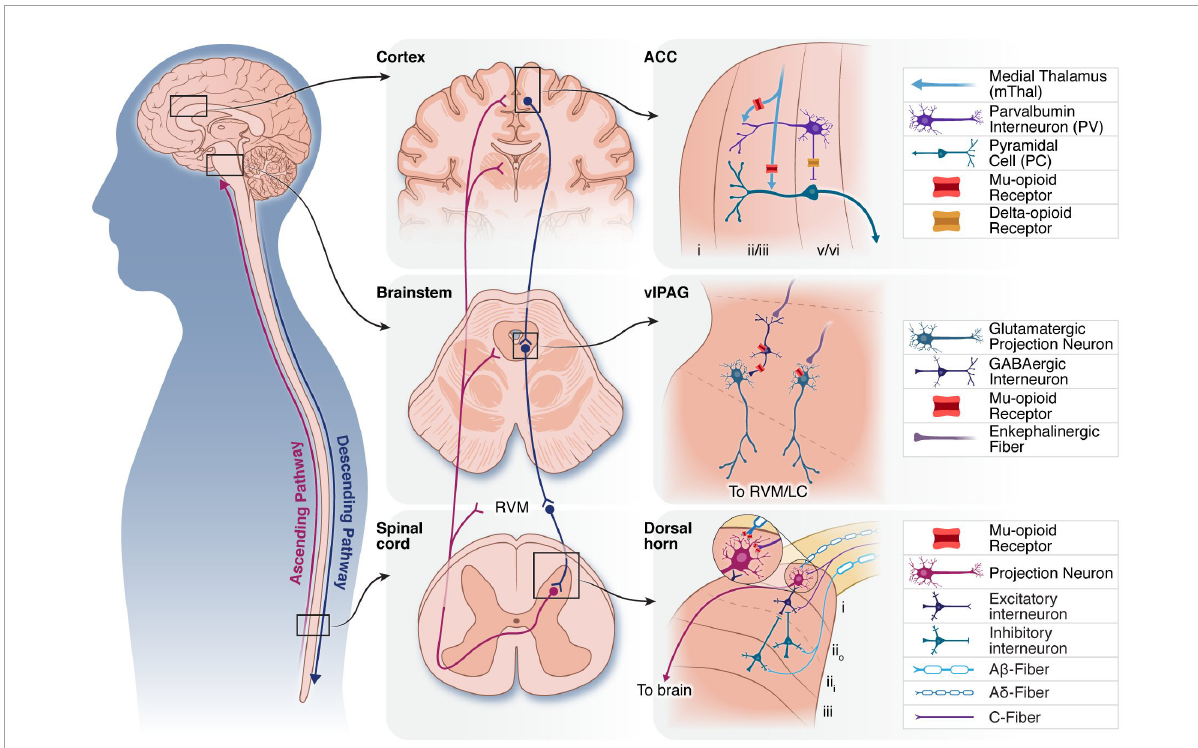
FIGURE1 Overview of three neural structures that have been targeted by neurostimulation therapies. Schematic of ascending (purple) and descending (blue) pain modulatory pathways (left) . Middle: Macro level anatomy of the cortex, brainstem and spinal cord, showing key nodes in the ascending and descending pain modulatory pathways. Connections between the brainstem and spinal cord via the RVM are indicated. Right: Select synaptic connections and microcircuitry of the ACC, vlPAG and DH are shown. Mu-and delta-opioid receptors are expressed on cell bodies and pre-synaptic terminals of neurons throughout the pain neuraxis to modulate ascending and descending pain pathways. ACC, anterior cingulate cortex; RVM, rostroventromedial medulla; vlPAG, ventrolateral periaqueductal gray; LC, locus coeruleus; DH, dorsal